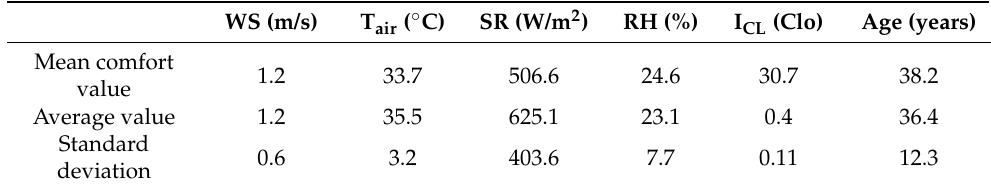
Table 10. Summary of the average values and standard deviation of weather data, clothing insulation and the age of the respondents for the comfort values of the